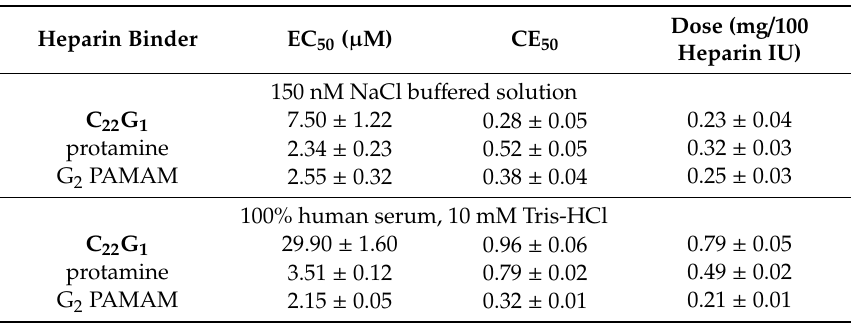
Table 1. Heparin binding data for C 22 G 1 , protamine, and the covalent G 2 PAMAM dendrimer in